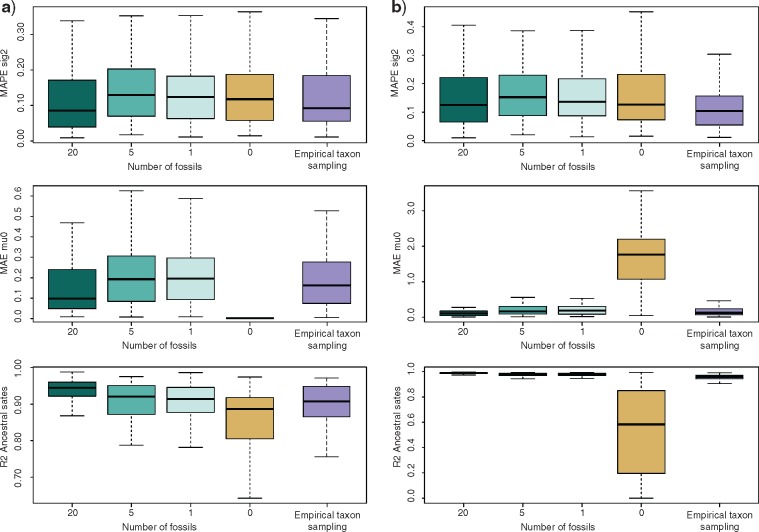
Accuracy of parameter estimation summarized across 100 simulations under Scenarios 1 and 2 and different levels of sampling. – The simulations assumed a constant rate Brownian evolution and either no trend (\documentclass[12pt]{minimal}
\usepackage{amsmath}
\usepackage{wasysym}
\usepackage{amsfonts}
\usepackage{amssymb}
\usepackage{amsbsy}
\usepackage{upgreek}
\usepackage{mathrsfs}
\setlength{\oddsidemargin}{-69pt}
\begin{document}
}{}$\mu_0 = 0$\end{document}, A) or a positive or negative evolutionary trend (\documentclass[12pt]{minimal}
\usepackage{amsmath}
\usepackage{wasysym}
\usepackage{amsfonts}
\usepackage{amssymb}
\usepackage{amsbsy}
\usepackage{upgreek}
\usepackage{mathrsfs}
\setlength{\oddsidemargin}{-69pt}
\begin{document}
}{}$\mu_0\ne$\end{document} 0; B). We tested decreasing number of fossils (20, 5, 1, and 0) and incomplete taxon sampling at the present. The latter setting (purple plots) was based on trees that reflected the size and sampling of the platyrrhine phylogeny analyzed here (200 extant taxa, 44% of which are sampled and 20 fossils). When the number of fossils was set to 0, only extant taxa were included in the analysis and the trend parameter (\documentclass[12pt]{minimal}
\usepackage{amsmath}
\usepackage{wasysym}
\usepackage{amsfonts}
\usepackage{amssymb}
\usepackage{amsbsy}
\usepackage{upgreek}
\usepackage{mathrsfs}
\setlength{\oddsidemargin}{-69pt}
\begin{document}
}{}$\mu_0)$\end{document} was not estimated but set to 0.